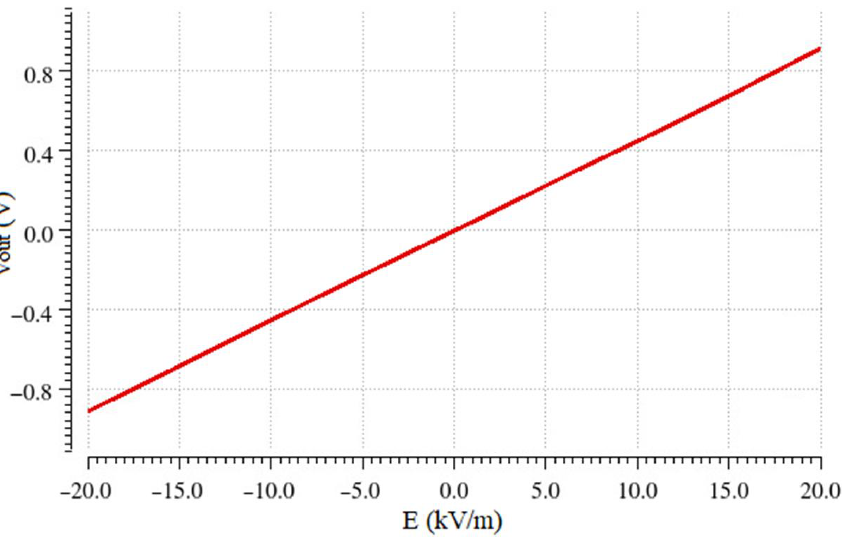
Table 22. Table of comparison of electric field mill analog front-end systems in the